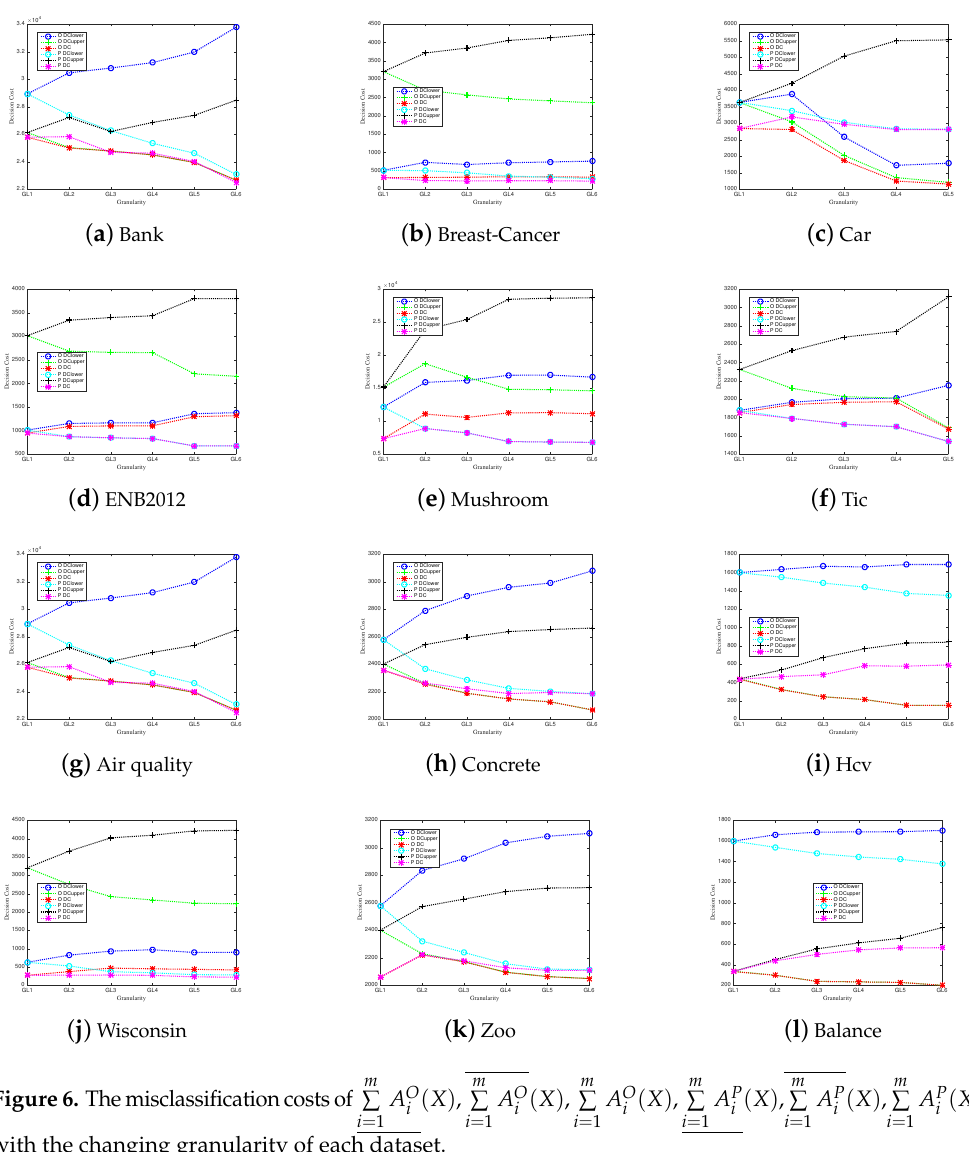
Figure 6. The misclassification costs of with the changing granularity of each